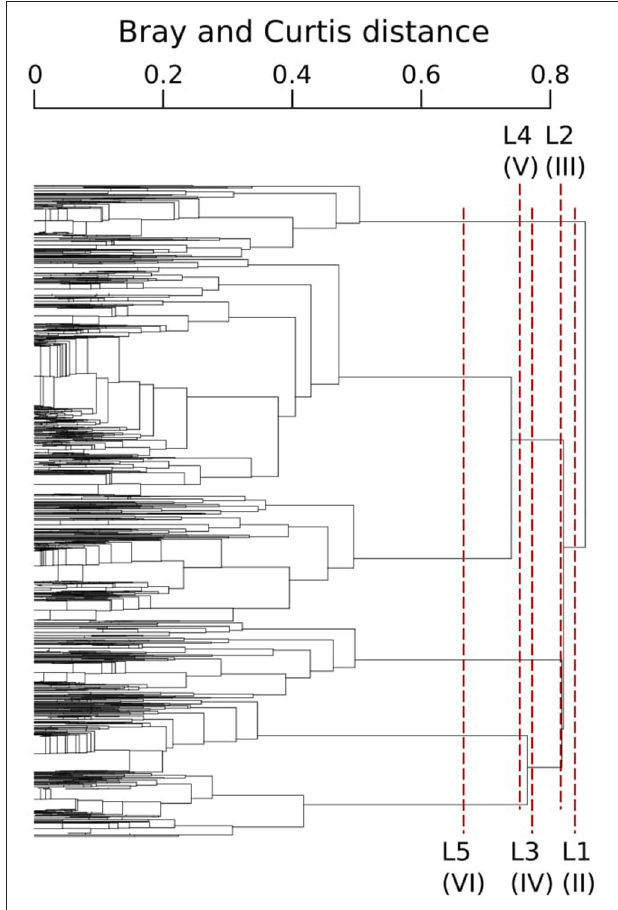
FIGURE 3 | CPR samples typology obtained from the Bray-Curtis dissimilarity measure of the standardized abundance of diatoms and an UPGMA clustering algorithm. Each branch represents a CPR sample. L x corresponds to x successive hierarchical clustering levels, giving a number of assemblages indicated by the roman number between